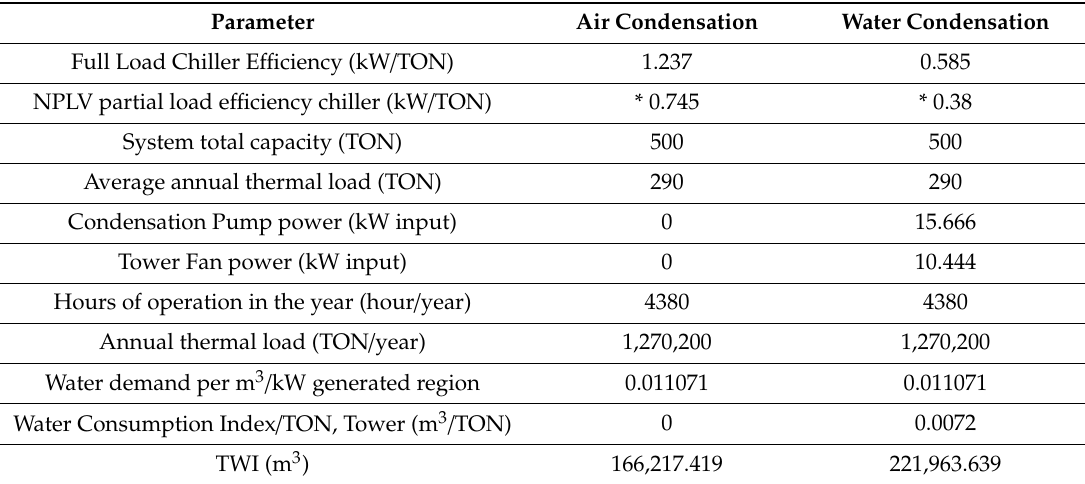
Table 2. 500 TON system